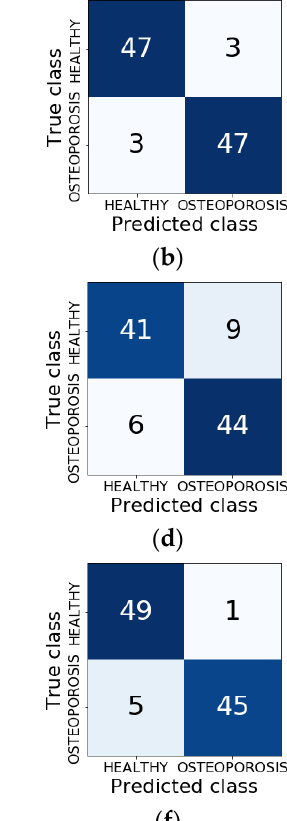
Figure 14. Images that were misclassified by the best VGG16 model.